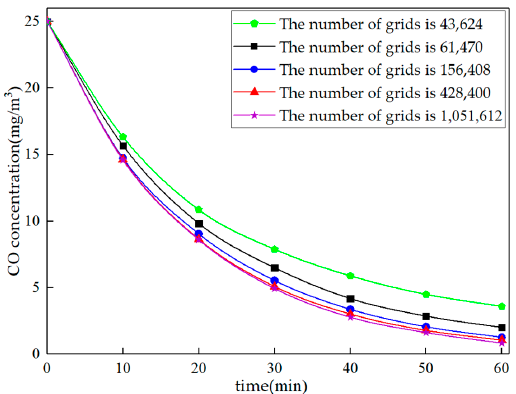
Figure 8. Grid independence verification.